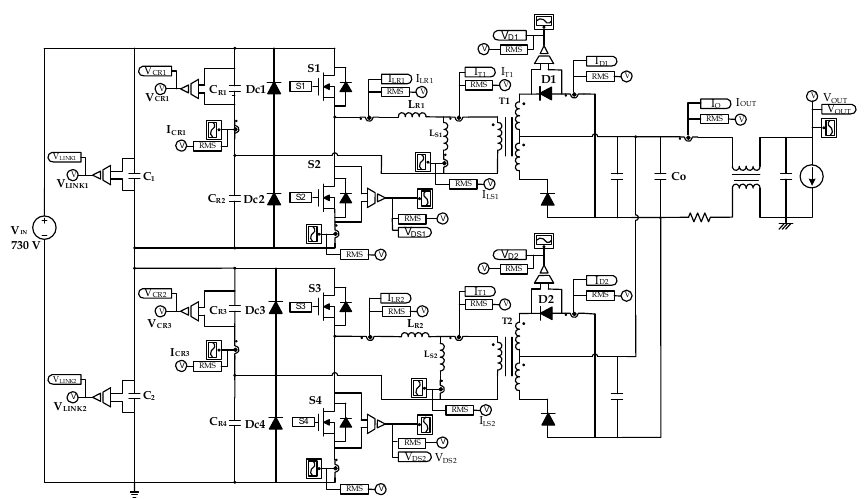
Figure 10. Simulation circuit of the auto-balancing converter.